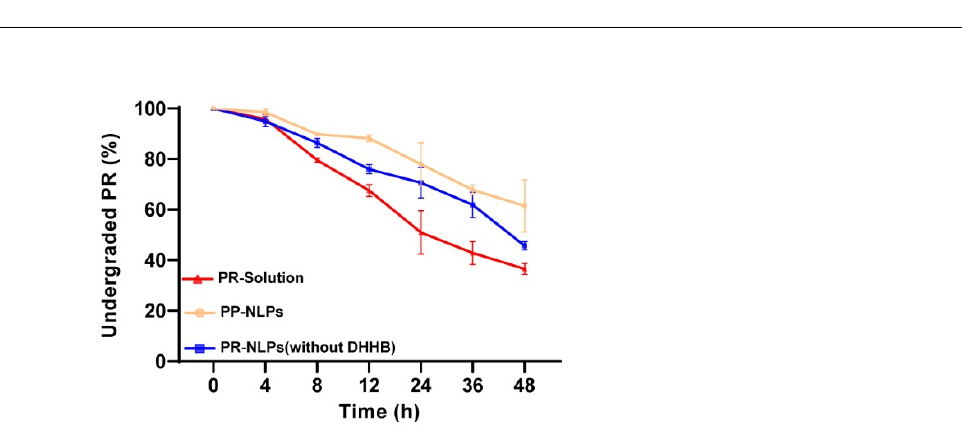
Table 2. ANOVA of quadratic model for responses of